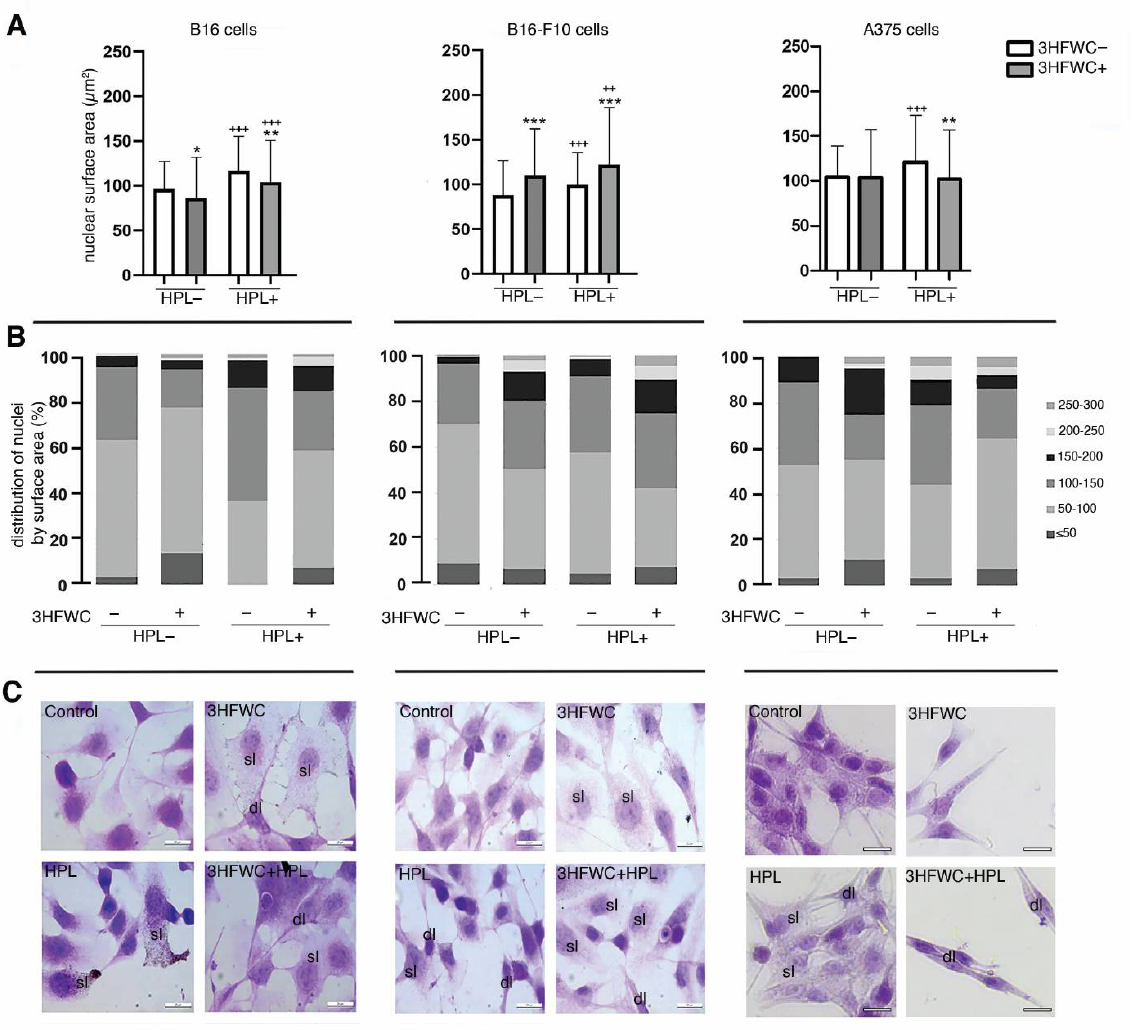
Figure 3. Morphometric and microscopic analysis of melanoma cells’ nuclei after the treatments with 3HFWC and/or HPL. ( A ) Average nuclear surface area ( µ m 2 ); ( B ) distribution of nuclei based on their surface area; ( C ) representative micrographs of hematoxylin and eosin (HE)-stained melanoma cells; sl—senescence-like; dl—dendritic-like phenotype (magnification and scale bar: × 1000, 20 µ m). Statistical significance, in comparison to untreated (control) cells: * if p < 0.05, ** p < 0.01, *** p < 0.001; in comparison to identical treatment regarding 3HFWC without HPL irradiation: ++ if p < 0.01, +++ p < 0.001.